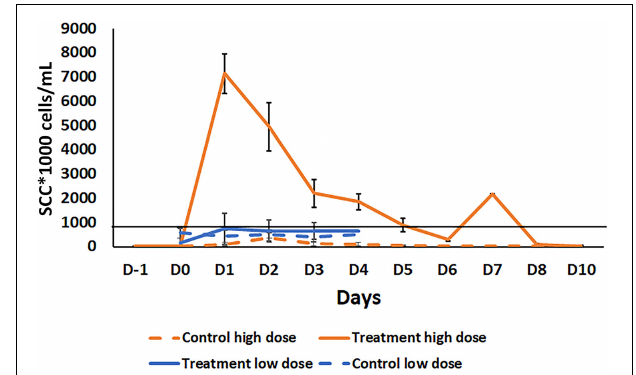
FIGURE 4 | Comparison of somatic cell count (SCC) in milk samples after intramammary inoculation of bovine with either a low (10 3 CFU) or high (10 9 CFU) dose of B. velezensis AP183. The black line across the graph indicates the bulk-tank SCC threshold that is 750,000 according to USDA. Treatment high dose: Treatment with a high dose (10 9 CFU) B. velezensis AP183; Control high dose: No treatment in high dose group; Treatment low dose: Treatment with low dose (10 3 CFU) of B. velezensis AP183; Control low dose: No treatment in a low dose group. Milk samples in high dose study were collected from pre inoculation day (D-i) to post inoculation days D o to D 10 . In the low dose study, milk samples were collected from D o to D 4 . Though the low dose and high dose inoculation were two different experiments with different animals at different times, all other procedures were the same. Significant differences were found between the low dose and high dose treatment groups in SCC count in milk samples collected from D o to D 4 (Di, P = 6.8 × 10 - 6 ; D 2 , P = 0.0005; D 3 , P = 0.04; D 4 , P =